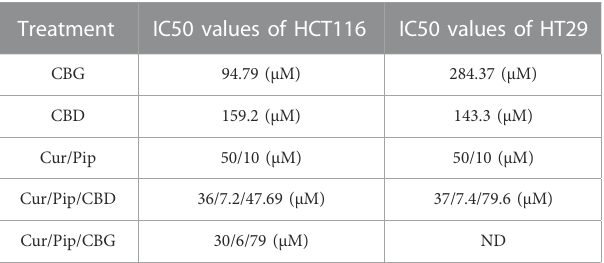
TABLE 1 IC50 values of treatment for HCT116 and HT29 cell lines.